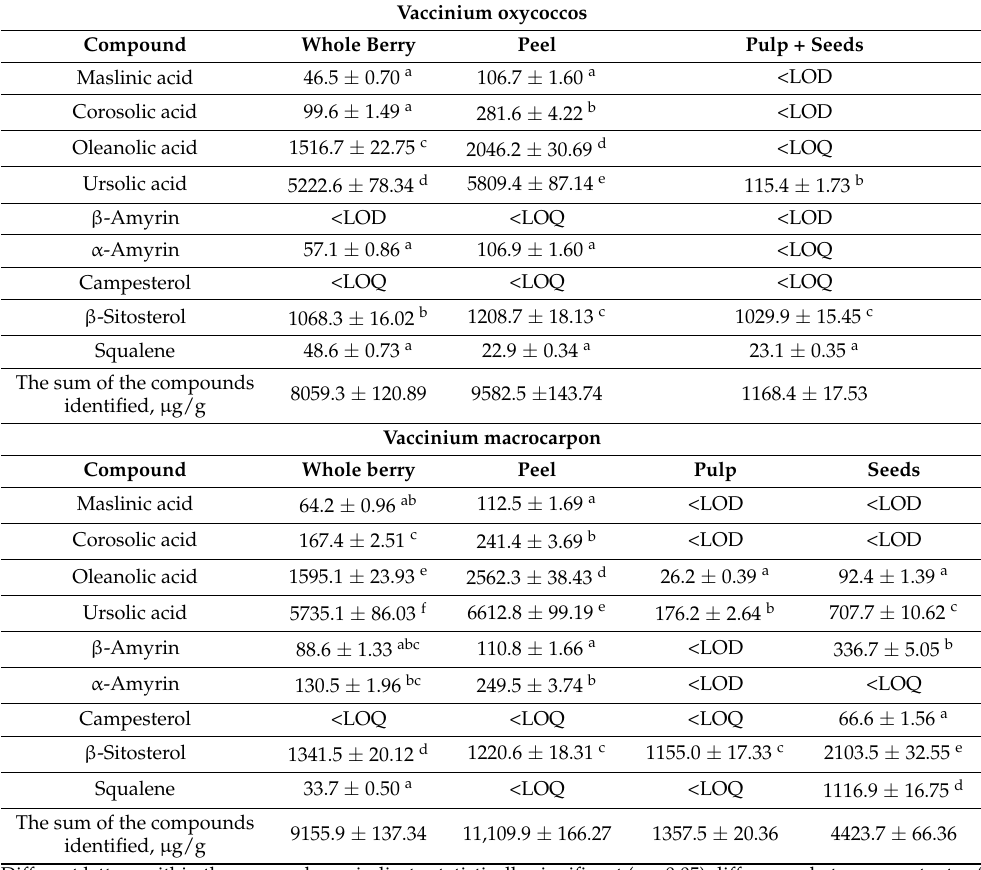
Table 4. Variability of triterpene compounds and phytosterols in samples of different parts of cranberry